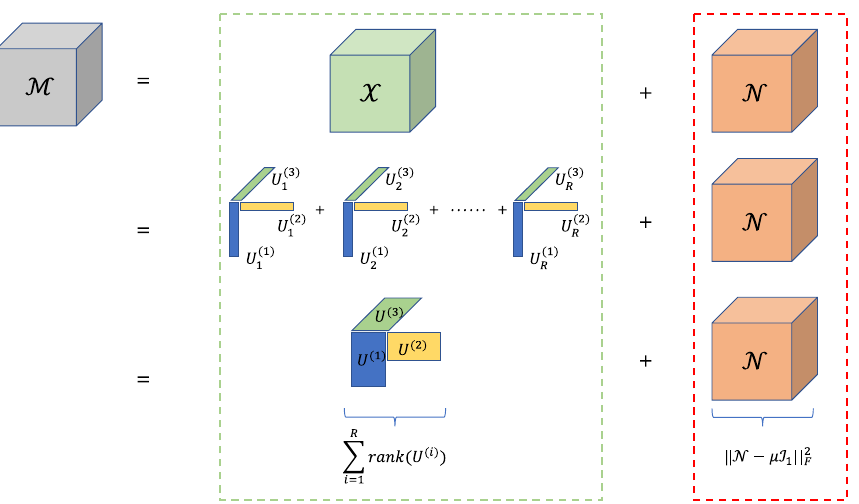
Fig. 1 The structure of the noisy tensor decomposition. The green box denotes the tensor that needs to be obtained and the red box denotes the noise